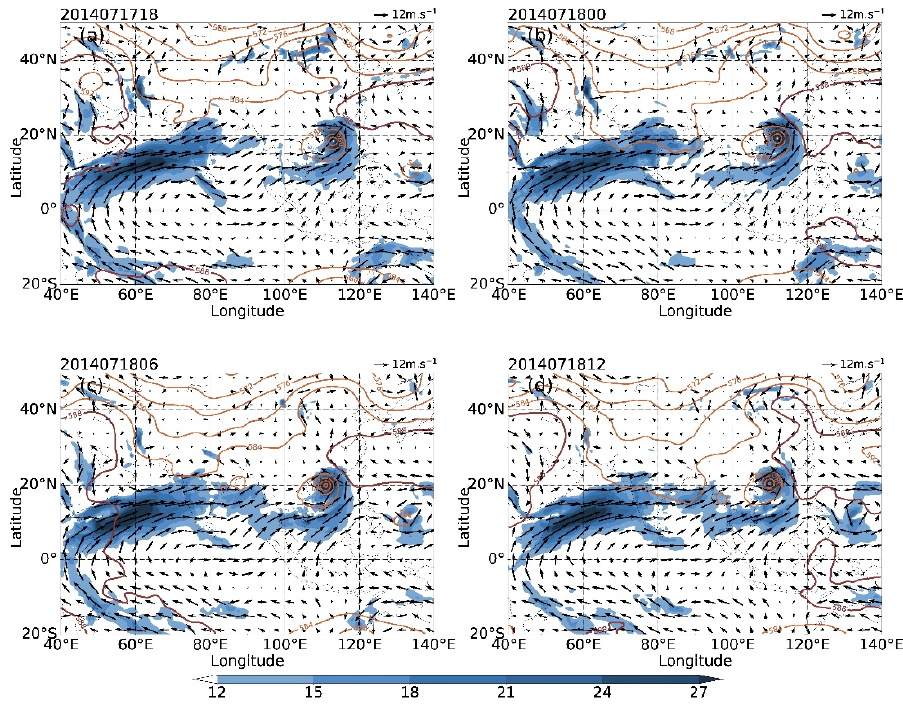
Figure 3. The 850 hPa wind field (vector, units: m · s − 1 ) and the 500 hPa geopotential height field (units: dagpm; the heavy solid line indicates the area of WPSH) at ( a ) 18 UTC 17 July; ( b ) 00 UTC 18 July; ( c ) 06 UTC 18 July; ( d ) 12 UTC 18 July. The shading shows the wind speed greater than or equal to 12 m · s − 1